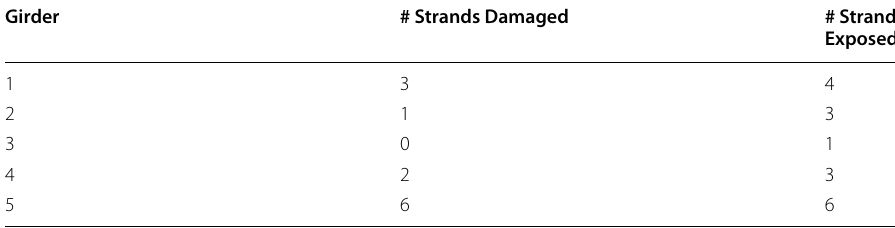
Table 3 The number of damaged and exposed strands in Damage Case-I Girder # Strands